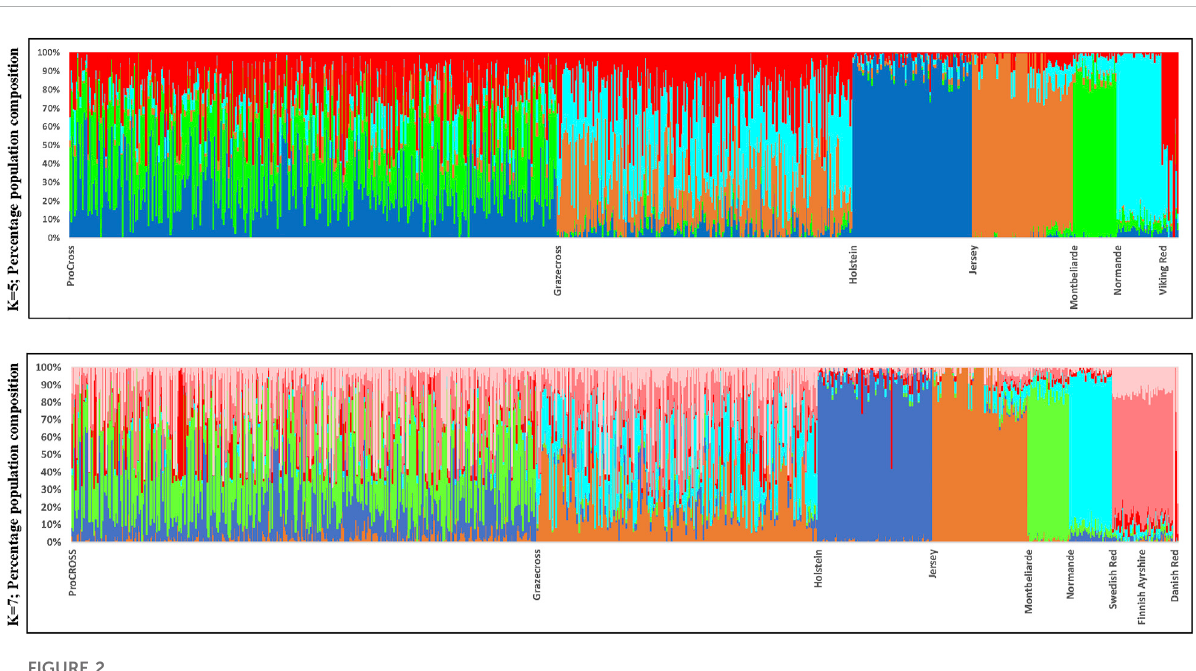
FIGURE 2 Admixtureanalysisre fl ectinggeneticclusteringofbreedsforbothProCROSSandGrazecrossadmixedandallparentalpopulationsfor K =5and K = 7. Individual vertical bars along the X -axis represent individual cattle grouped by breed; Y -axis provides a measure of the composition of each genetic population found within